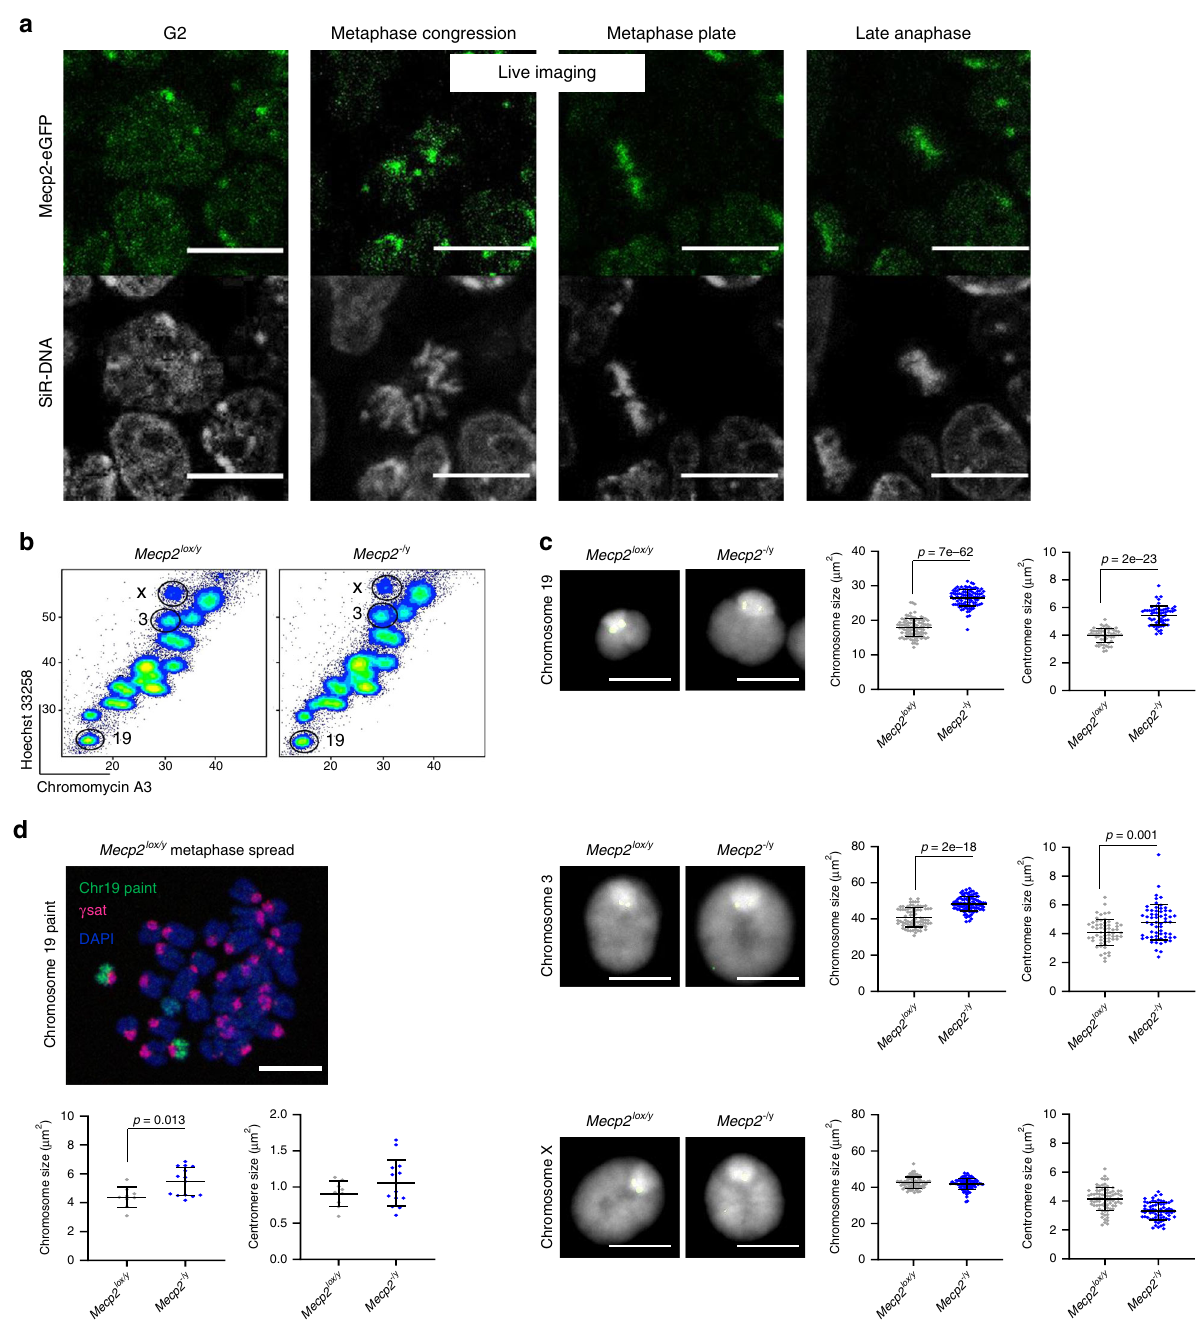
Fig. 3 Increased size of mitotic chromosomes in ESCs lacking Mecp2. a Mecp2 association with chromatin throughout mitosis using live cell imaging of Mecp2-eGFP fusion protein in ESCs. Selected time frames from the same dividing cell are shown. Scale bar = 14 μ m. Images are representative of three independent experiments. b Flow karyotype of mitotic chromosomes isolated from Mecp2 lox/y or Mecp − /y ESCs. Gates used to isolate chromosomes 19, 3 or X are indicated. Images are representative of three independent experiments. c Representative images of mitotic chromosomes 19, 3 and X from Mecp2 lox/y and Mecp2 − /y ESCs are shown, where DAPI stain (grey) and Cenpa label (green) indicate the chromosome body and centromere, respectively, scale bars = 5 μ m. Chromosome and centromere sizes were calculated for each ESC line by measuring individual chromosomes (chromosome 19: n = 100 and 100; chromosome 3: n = 80 and 100; chromosome X: n = 100 and 100) and centromeres (chromosome 19: n = 55 and 60; chromosome 3: n = 60 and 60; chromosome X: n = 80 and 70) over three independent experiments, mean ± SD are shown. d Representative image of Mecp2 l ox/y ESC metaphase spread stained with chromosome 19 painting probe (green), gamma satellite probe ( γ sat, pink) and DAPI (blue), scale bar = 4 μ m. Chromosome and centromere sizes of chromosome 19 were calculated by measuring metaphase spreads of Mecp2 l ox/y ( n = 8) or Mecp2 − /y ( n = 14) ESCs, mean ± SD are shown. c , d P -values of statistically signi fi cant increases, measured by unpaired two tailed Student ’ s t -tests, are indicated. Source data are provided as a Source data fi